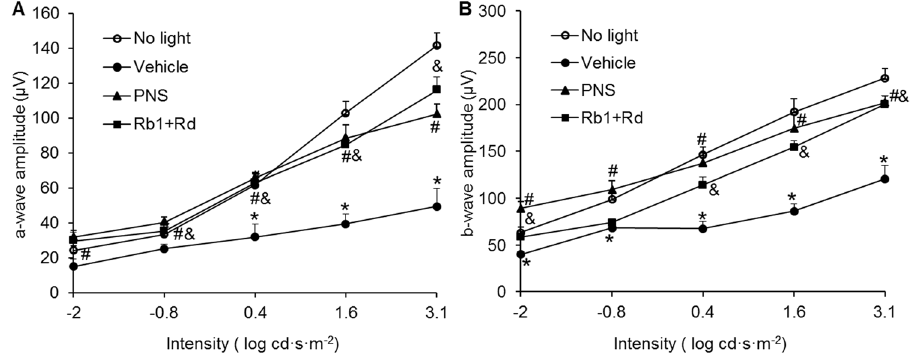
Figure 3. PNS or Rb1 and Rd combination preserved retinal function in bright light-exposed mice. BALB/c mice were treated with vehicle, PNS at 200 mg/kg bw, or natural combination of Rb1 and Rd 30 min before bright light exposure. Retinal function was examined 10 d after bright light exposure. Scotopic ERGs were recorded and amplitudes of a-wave ( A ) and b-wave ( B ) were plotted. Data were expressed as mean ± S.E.M (n = 4–5 per group). * Compared to that from No light, p < 0.05; # PNS treatment was compared to that from Vehicle, p < 0.05; & Combination treatment of Rb1 and Rd was compared to that from Vehicle, p < 0.05.